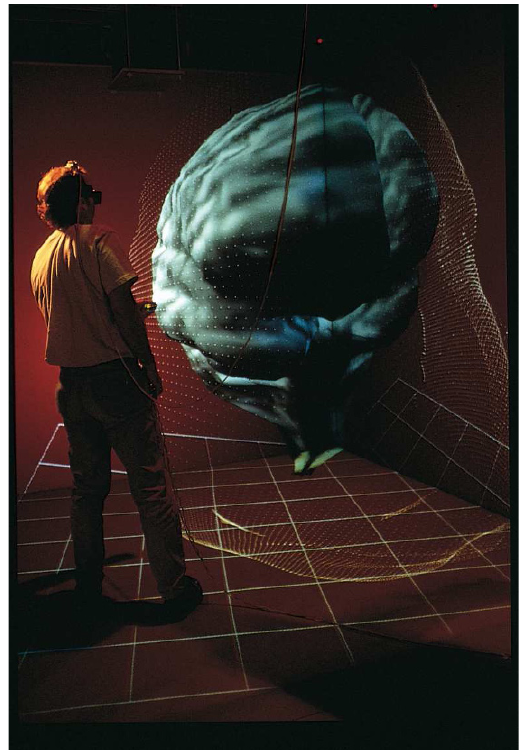
Figure 1. The “classic” CAVE is a multi-person, room-sized, high- resolution, 3D video and audio environment. Early CAVEs had less than a megapixel per wall per eye; newer ones have up to 15 times as many pixels. Photo: National Cen- terforSupercomputingApplicationsatUniversityofIllinois at Urbana-Champaign. Note: All the photographs, unless otherwise noted, in this paper were shot with the stereo turned off so the images are not doubled.